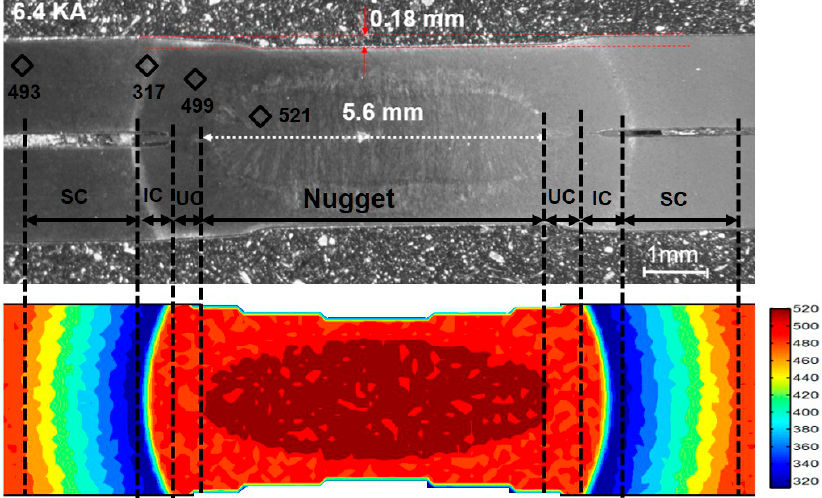
Figure 11. Typical microhardness distribution at the cross section of the nugget with a welding current of 6.4 kA.